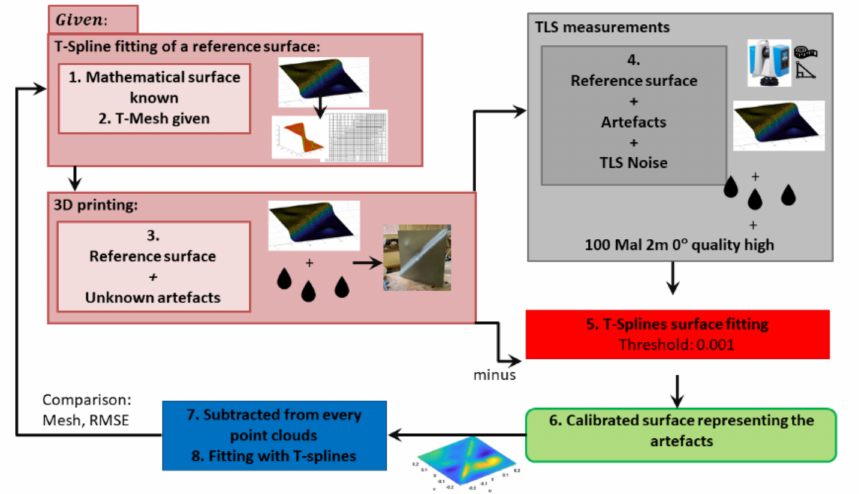
Figure 5. Methodology for the calibration of the 3D-printed surface scanned with TLS under various scanning